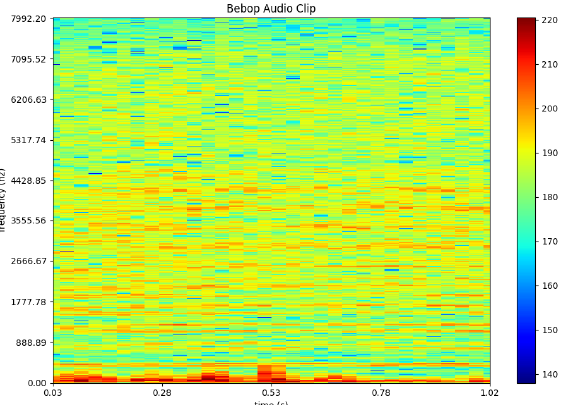
Figure 3. Example of drone noise in spectrogram representation © [2019] IEEE. Reprinted, with permission, from [38].